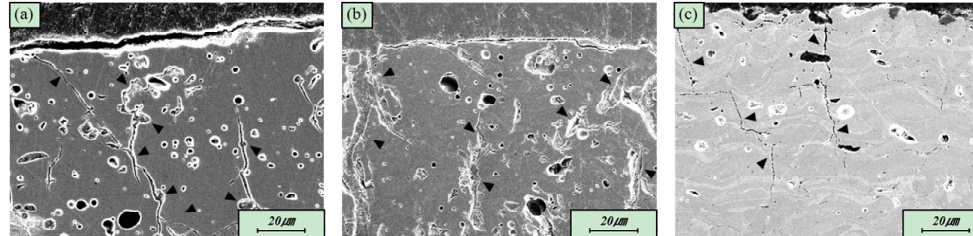
Figure 8. SEM micrographs showing the microstructure on the cross-section of the EB after thermal shock test at 1350 °C: ( a ) mullite, 5000 cycles; ( b ) mullite + Yb 2 SiO 5 , 5000 cycles; and ( c ) Y 2 SiO 5 , 5000 cycles.